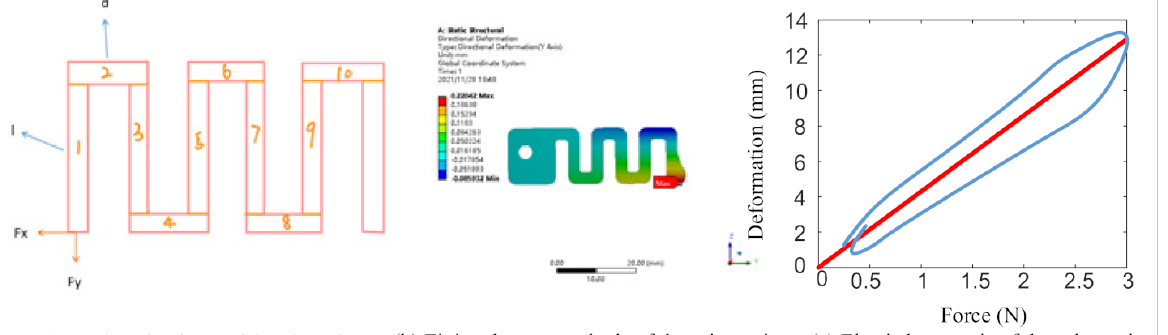
Figure 7. Model and analysis of the